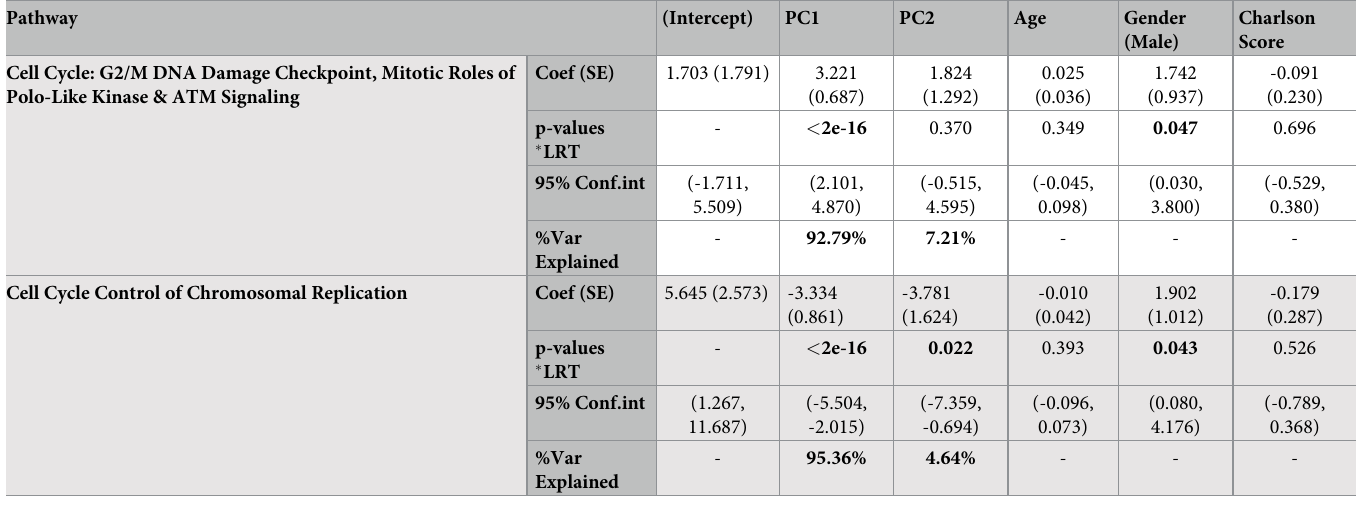
Table 2. Regression models for genes associated with COVID-19 status.